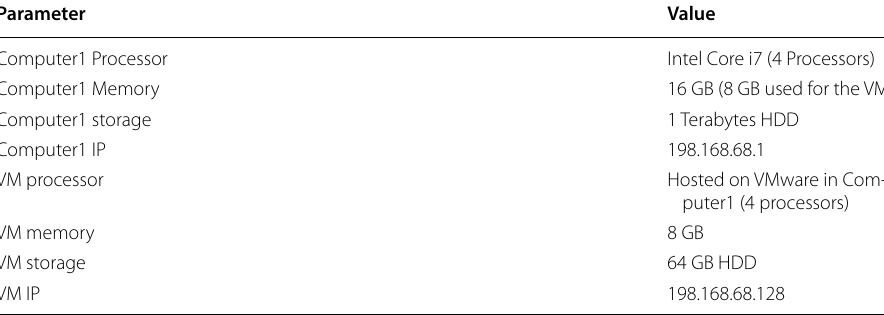
Table 1 Hardware configuration